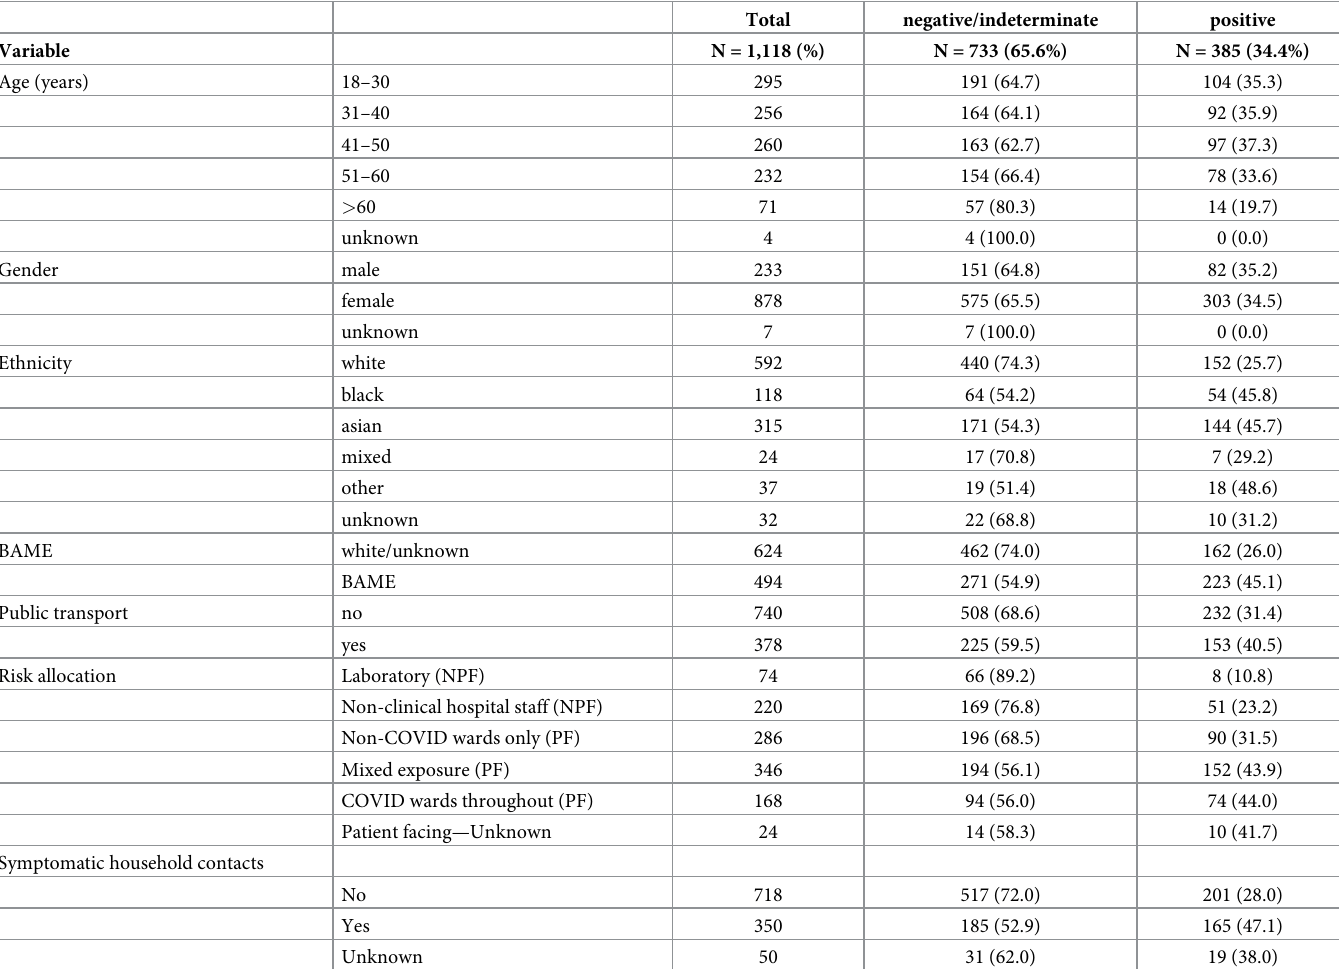
Table 1. Demographics of all 1118 staff by evidence of infection (positive serology or positive PCR versus negative for both tests). Values are all n (%) with p-values from chi-square tests (see S2